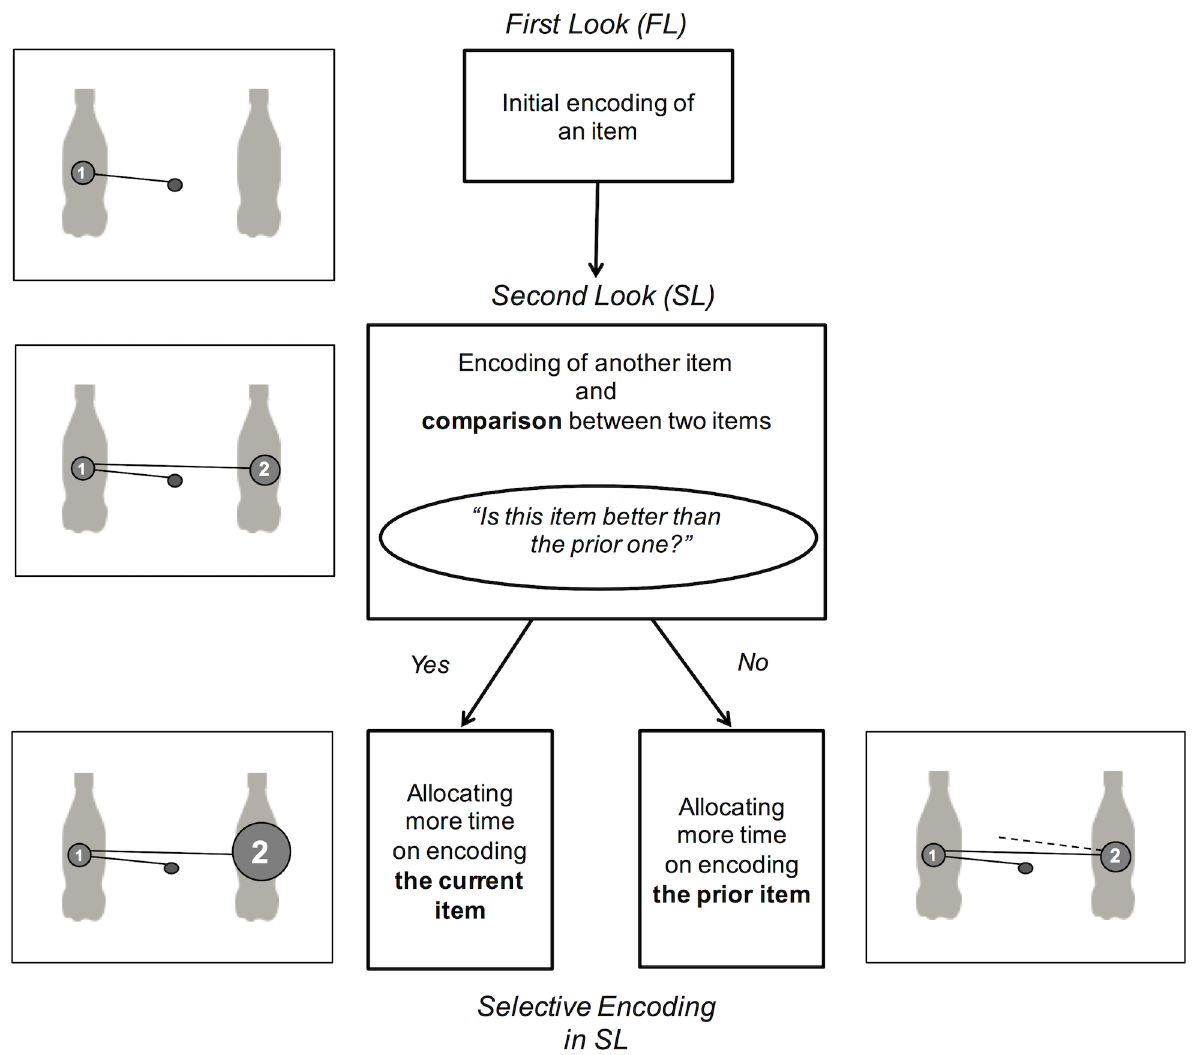
Fig 2. A schematic representation of selective encoding in the 2AFC paradigm suggested and examined in the present study. At the time of the first look (FL) (i.e., initial encoding stage), participants cannot know whether an item is more appropriate than another item; thus, selective encoding does not occur. On the other hand, at the time of the second look (SL) (i.e., encodingand comparisonstage), participants know all the items presented and they can judge which item meets their decisioncriteria better. Therefore, selective encoding occurs only in the SL, and not in the